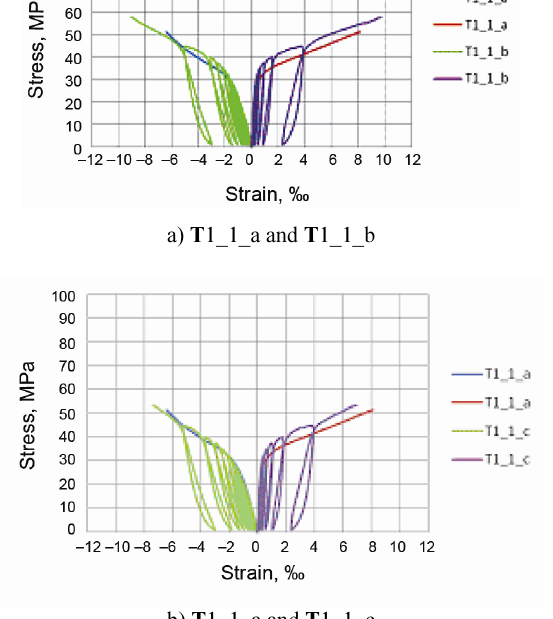
Fig. 8. Cyclic and monotonic stress-strain curves for T 1_1_a/b and T 1_1_a/c specimens